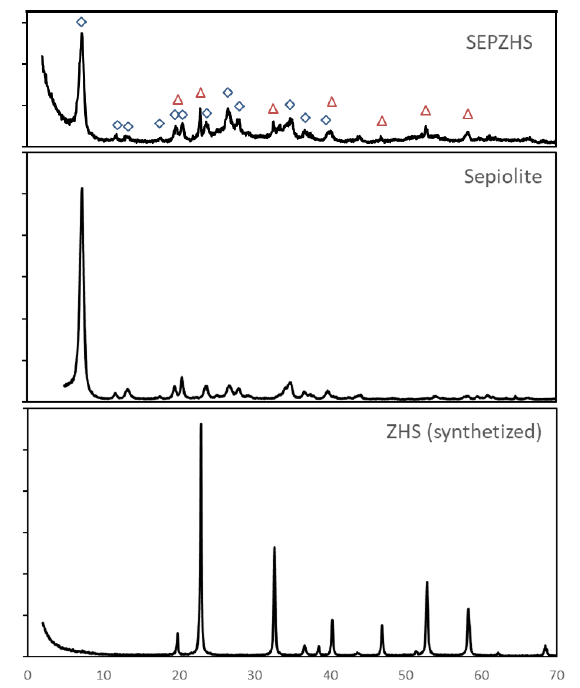
Figure 5. XRD for SEPZHS additive, sepiolite, and ZHS synthesized. Corresponding peaks of sepiolite ( ♦ ) and ZHS ( ∆ ) are marked in the SEPZHS diffractogram.